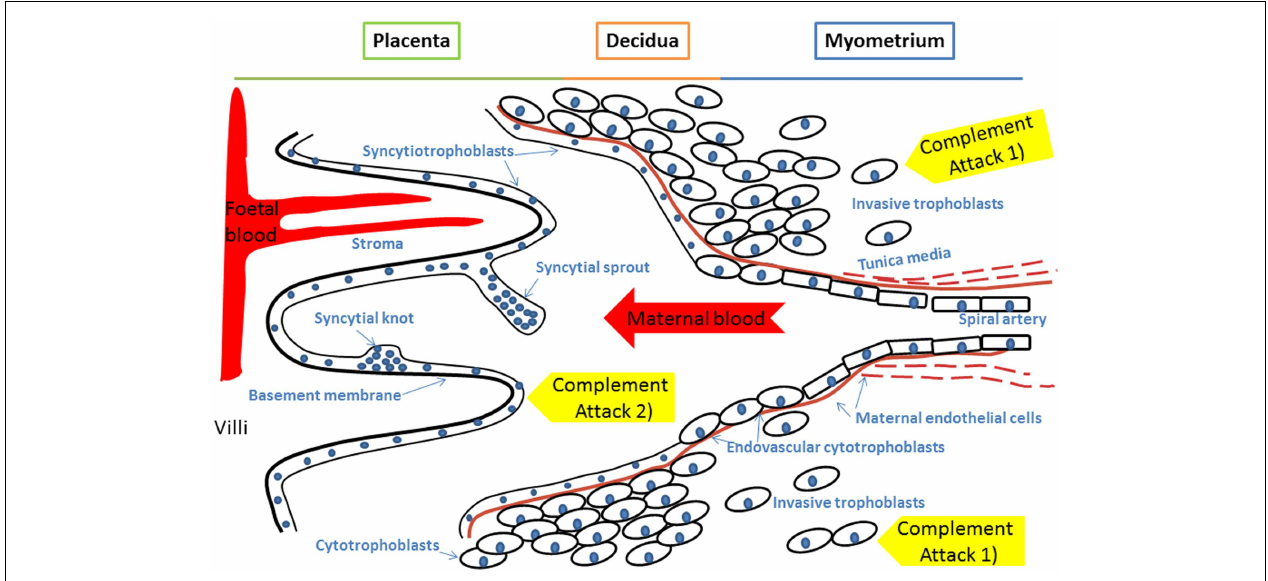
that represent the discordant interfaces. Accordingly, an imbalance between complement activation and regulation could contribute to the pathogenesis of preeclampsia. Specific foci for complement to attach could include syncytial bodies (apoptotic syncytial knots and syncytial sprouts), which are observed more often in preeclamptic placentae than in healthy